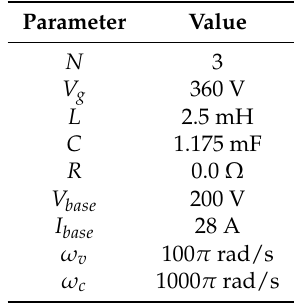
Table 2. Parameters used in Simulink/MATLAB